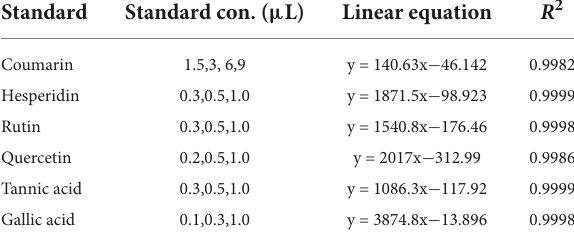
TABLE 1 The standards, standards concentrations, and linear